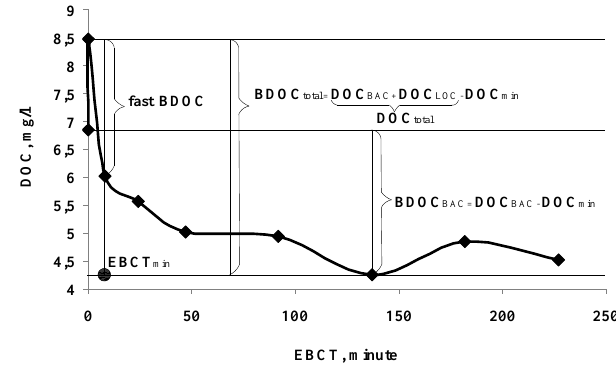
Figure 3. Principle of BDOC quantification shown on an example of 30h feeding of BAC water sample supplemented with NaAc as a